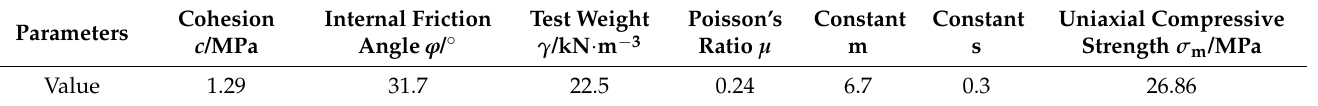
Figure 5. Variation curve of pillar safety coefficient F with pillar height h . Table 1. Relevant parameters of rock and soil at the ore-rock